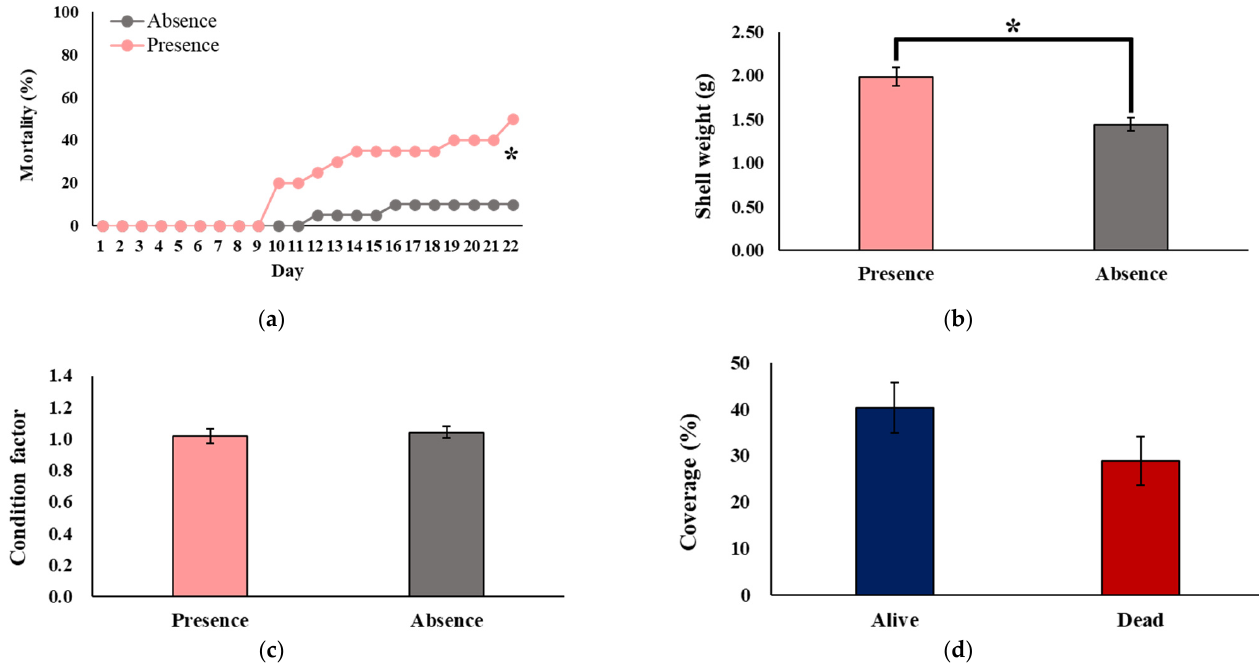
Figure 3. ( a ) Mortality, ( b ) shell weight, and ( c ) CF of limpets in the presence or absence of coralline algae on the shell. ( d ) The coverage area (%) of the coralline algae from alive or dead limpets within the group in which coralline algae are present on the shell. Values for shell weight, CF, and coverage area are indicated as mean ± SE. Asterisks indicate significant differences between groups ( p < 0.05).